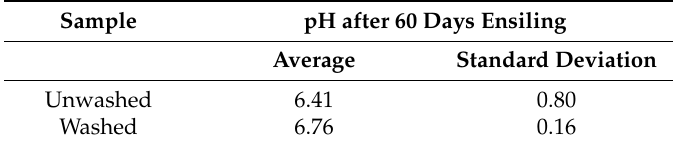
Table 5. pH of washed and unwashed S. muticum after ensiling for 60 days (n = 3). Sample pH after 60 Days Ensiling Average Standard Deviation Unwashed 6.41 0.80 Washed 6.76 0.16